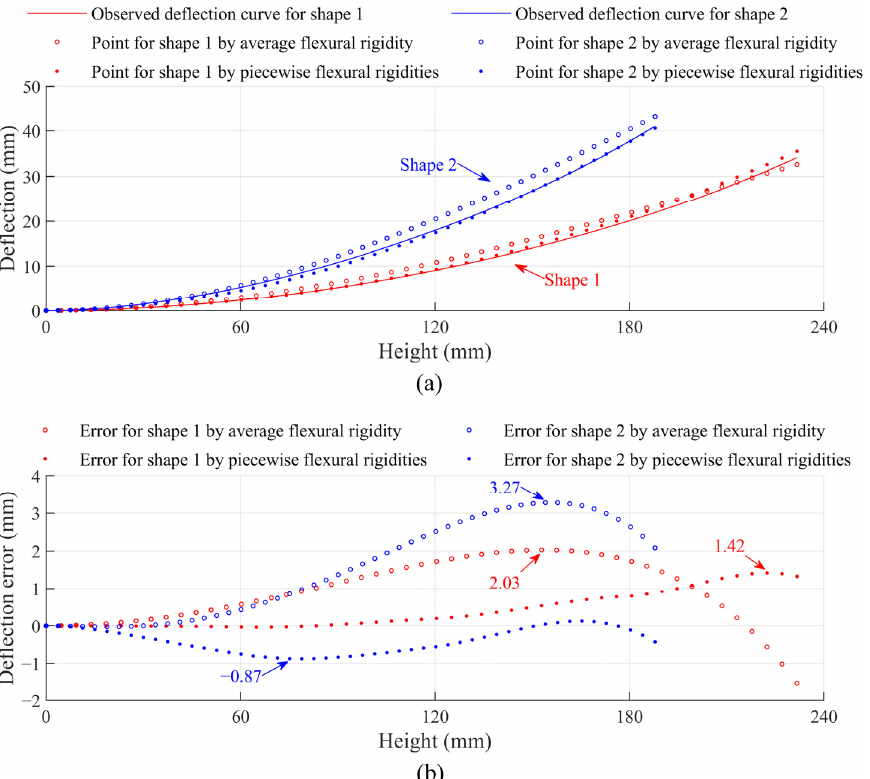
Figure 9. ( a ) Observed deflection curves and calculated points for two bending shapes of a tea stalk. ( b ) Errors between observed deflections and calculated deflections for two bending shapes of a tea stalk.